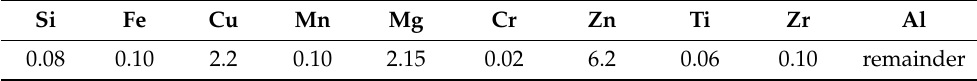
Table 1. Chemical Composition of 7050 Aluminum Alloy